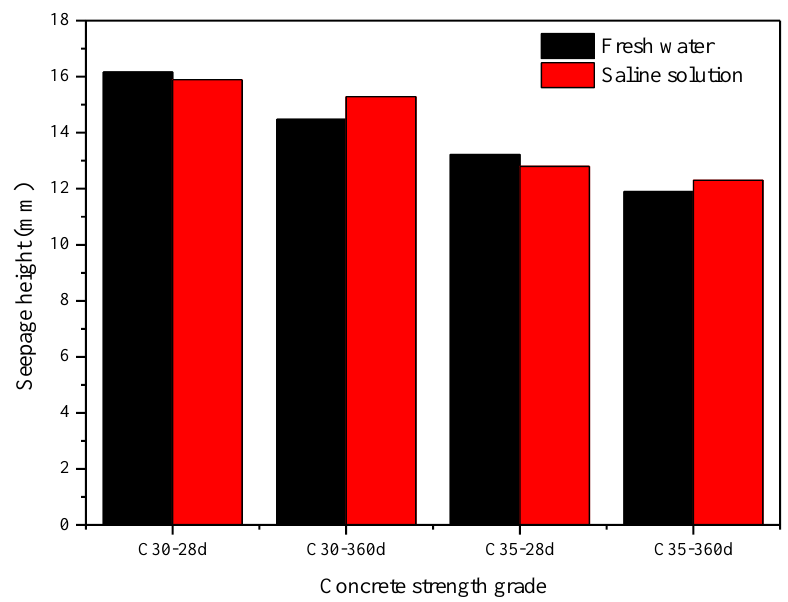
Figure 9. Concrete water penetration height test results.